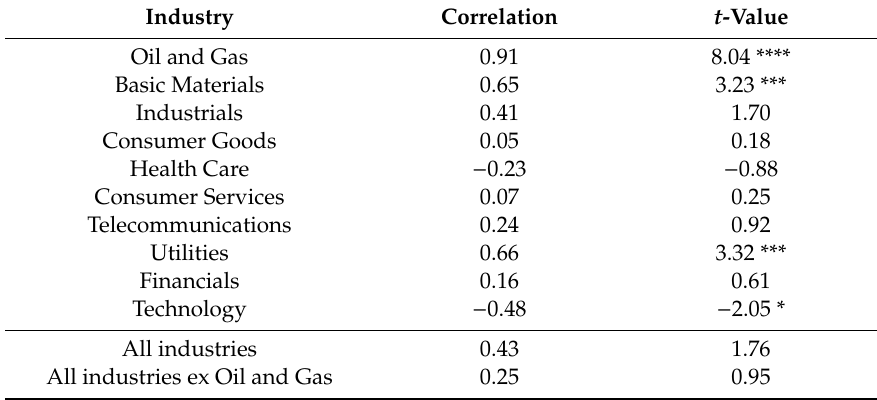
Table 10. Correlations for pseudo-log returns between the GPFG and the GPCF,